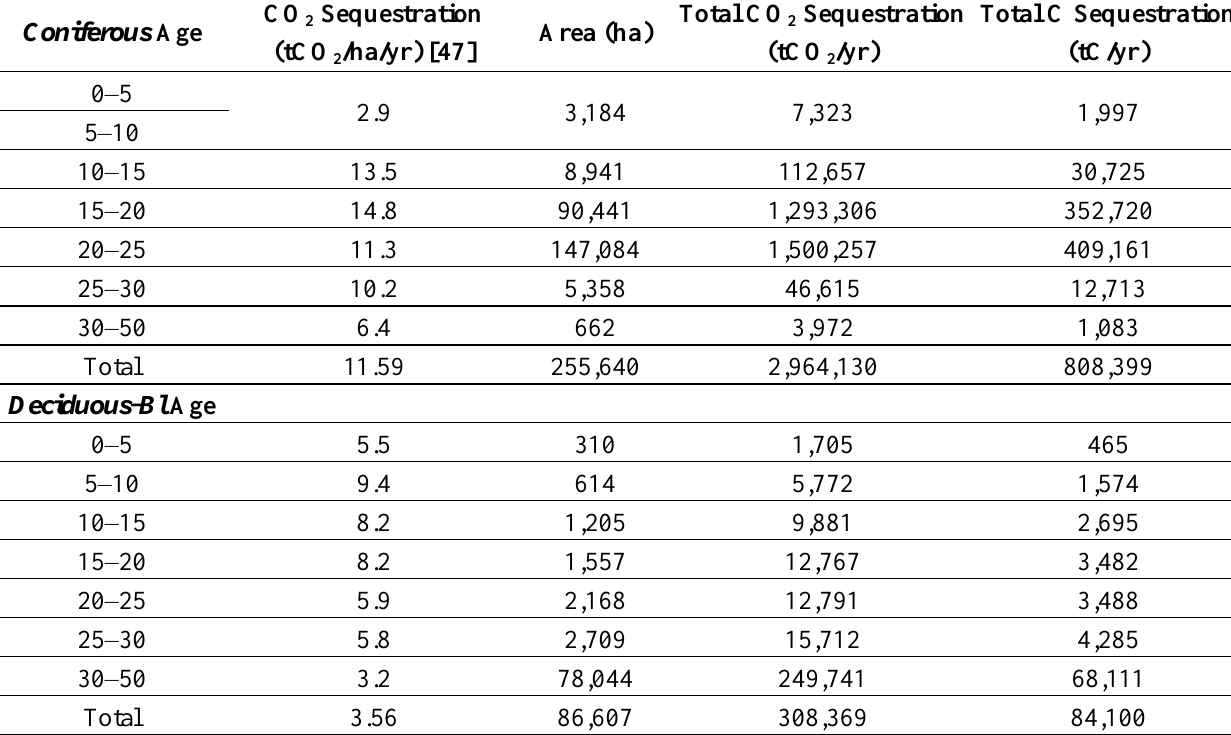
Table 7. CO sequestration of coniferous and deciduous broadleaf forests per tree age 2 using the PALSAR data and the stem volume